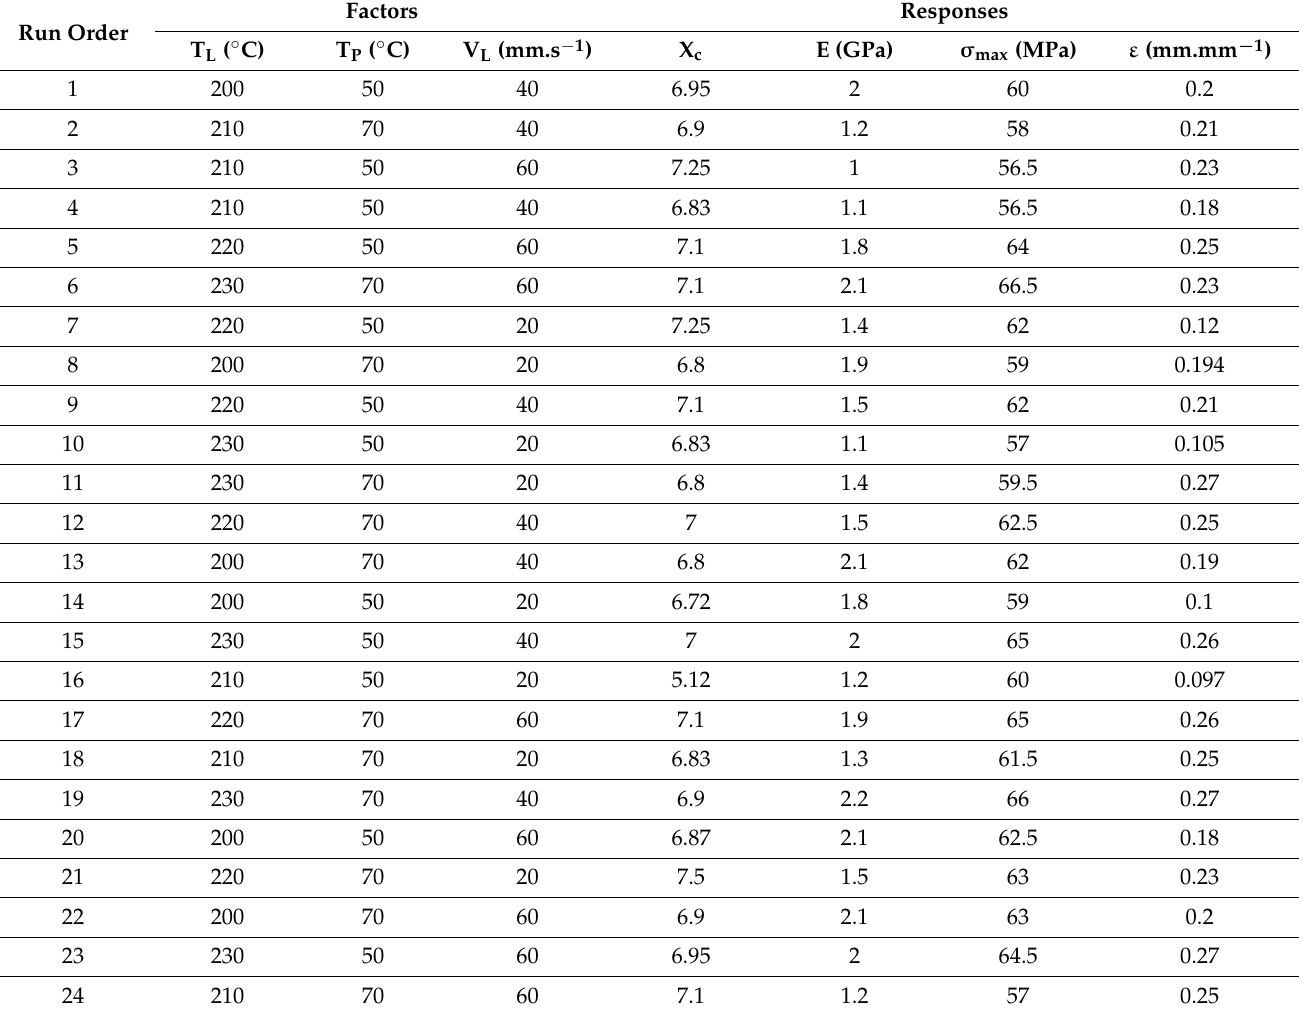
Table 2. Various characteristics for PLA samples at various